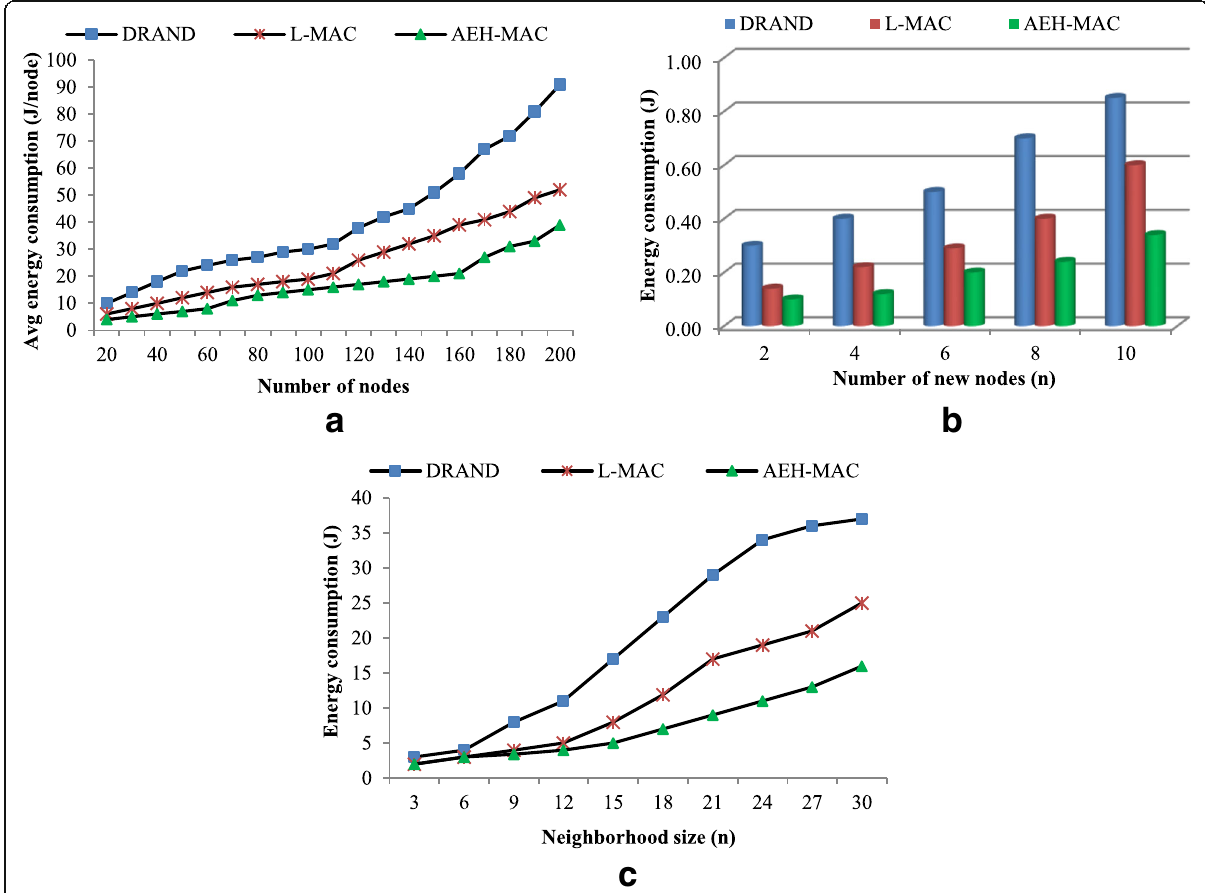
Fig. 12 Energy consumed during the scheduling process: ( a ) Nodes vs. Average energy ( b ) New nodes vs. Energy consumption ( c ) Neighborhood size vs. Energy